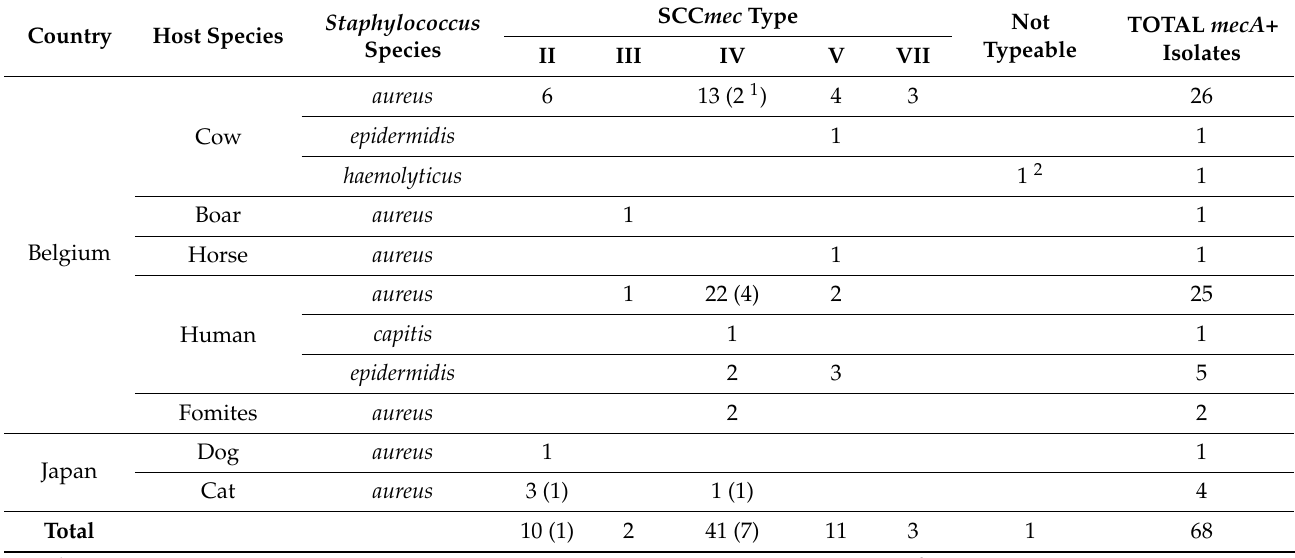
Table 2. Identification by multiplex PCR (mPCR) and whole genome sequencing (WGS) of the staphylococcal